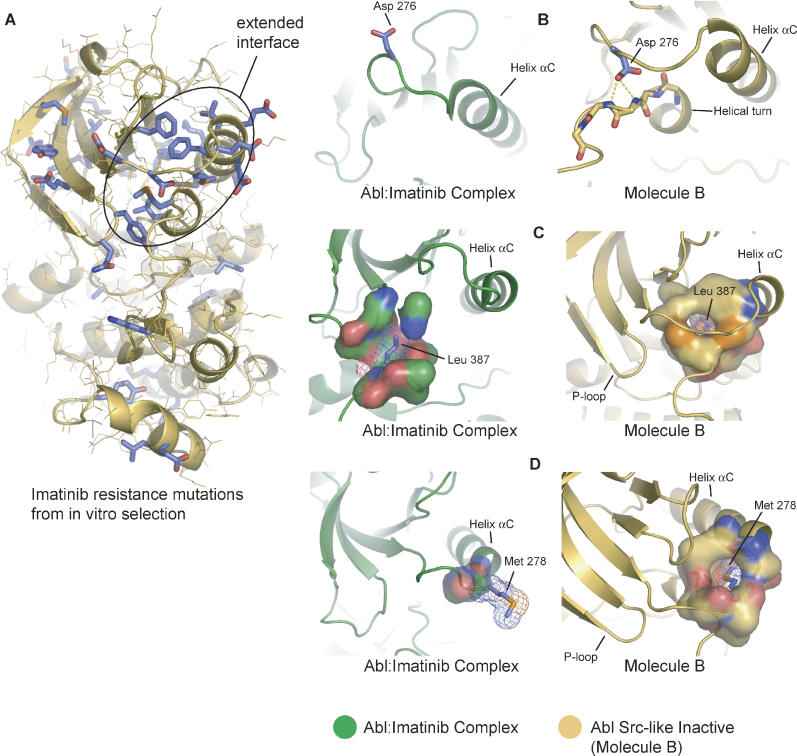
Molecule B Helps Explain Mutations in the Kinase Domain of Abl That Confer Resistance to Imatinib(A) The side chains of residues implicated in imatinib resistance in the Azam et al. study [
48] are shown in blue in the context of molecule B. A large number of these mutations cluster in the interface between helix αC, the N-lobe, and the helical turn in the activation loop.
(B–D) For three of these mutations we have shown the surface for all atoms within 6 Å of the mutated residue in the context of different structures. The Abl:imatinib complex is in green and the Src-like structure (molecule B) in yellow-orange. (B) Asp 276. (C) Leu 387. (D) Met 278.